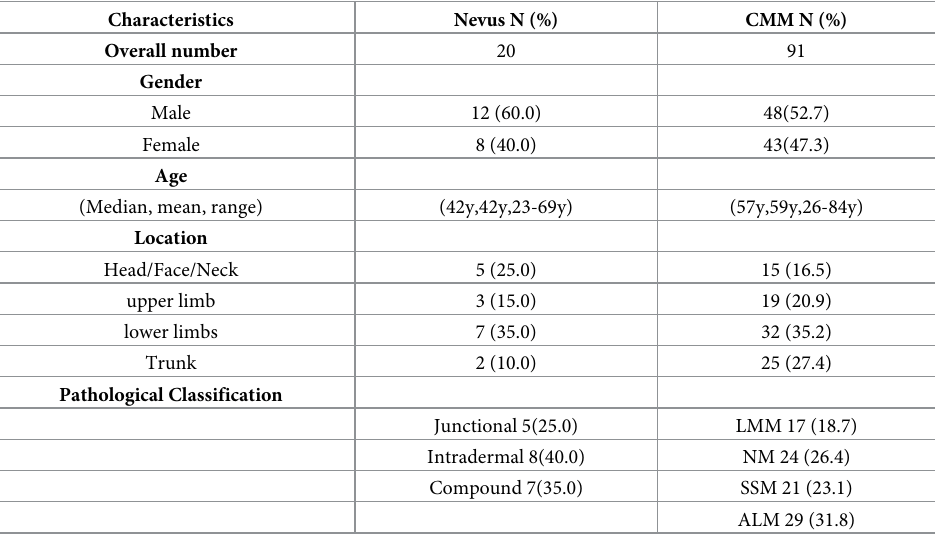
Table 1. Clinicopathological features of Nevus and